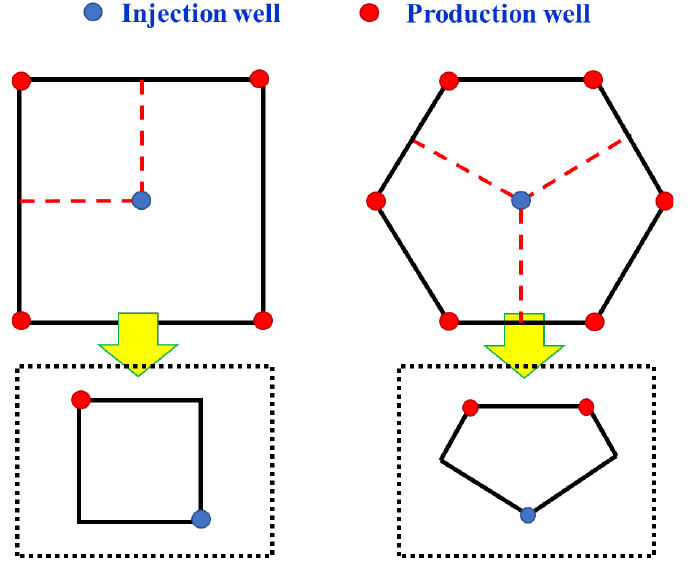
Figure 4. The design of the plate core with reverted seven-spot well pattern and five-spot well pattern.